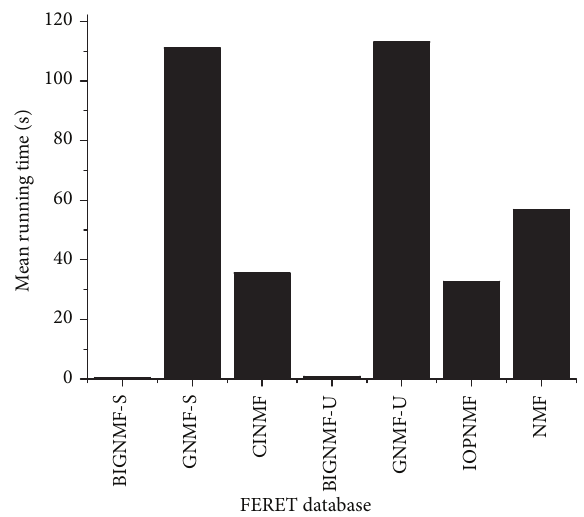
Figure 7: The mean running time during incremental study with images belonging to one class for the FERET database.